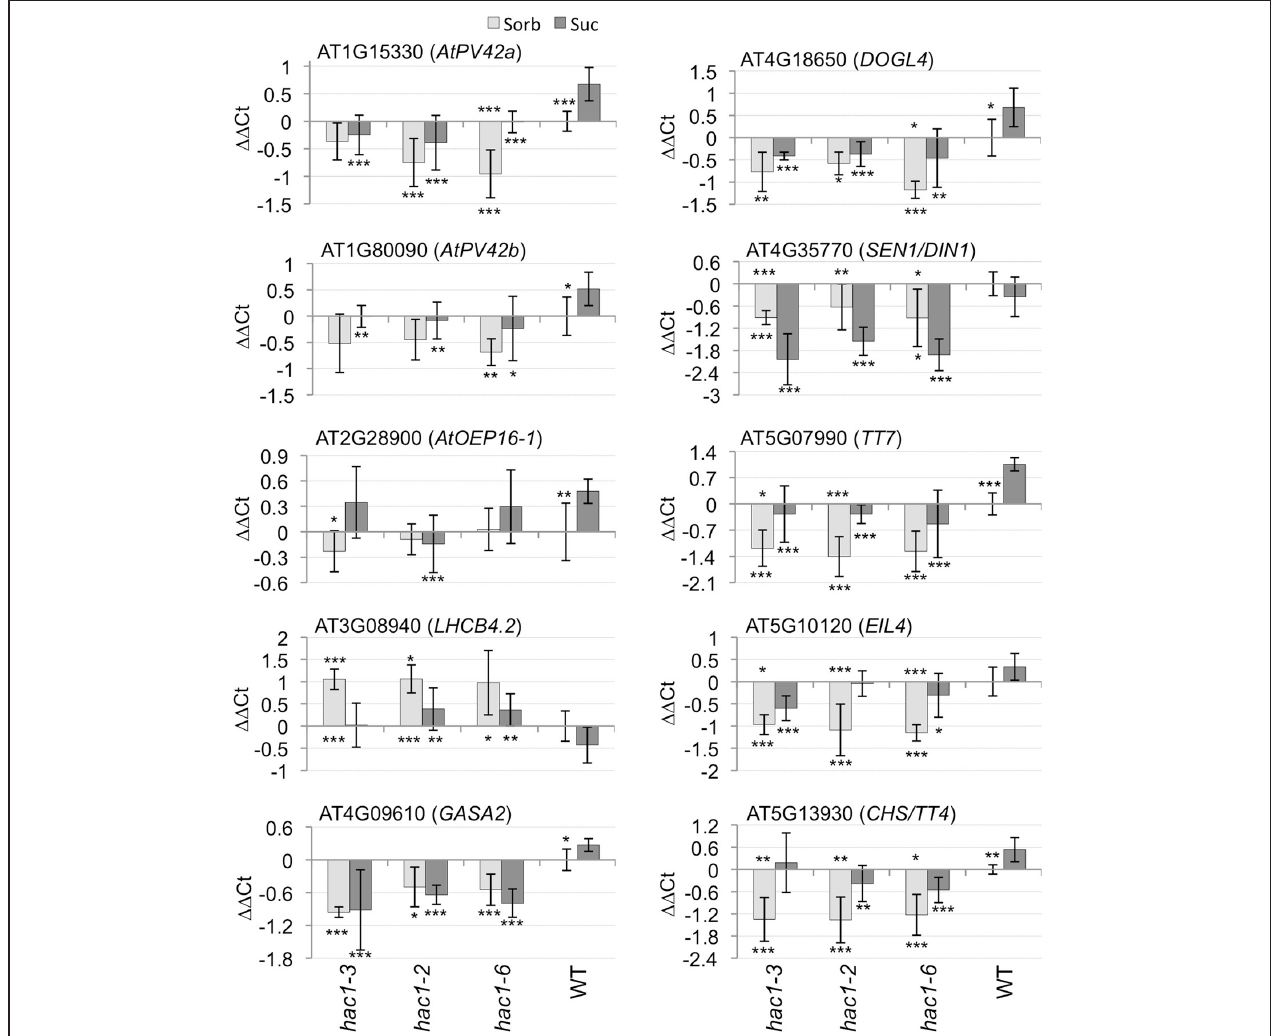
indicate that transcript levels for the indicated gene are higher in FIGURE 6 | Mutations in HAC1 cause altered expression of the indicated line on the indicated media than in wild-type seeds specific genes. Mutant and wild-type (WT) Arabidopsis seeds were incubated on sorbitol. Conversely, negative (cid:2)(cid:2) Ct values indicate surface sterilized and then incubated in the dark at 4 ◦ C for 3 days prior to being sown on nytex screens on Petri plates that transcript levels for the indicated gene are lower in the containing solid minimal Arabidopsis media. The seeds were indicated line on the indicated media than in wild-type seeds incubated under continuous light at room temperature for 20h, incubated on sorbitol. Two technical replicates were performed for and then the nytex screens and seeds were transferred to Petri each biological replicate. Error bars indicate standard deviations. plates containing Arabidopsis minimal media supplemented with The results of Student’s t -tests comparing transcript levels for 0.1M sorbitol (Sorb) or Suc. After an additional 12–13h, seeds seeds germinated on 0.1M sorbitol vs. seeds of the same line were harvested, followed by isolation of RNA. Quantitative RT-PCR germinated on 0.1M Suc are indicated by asterisks above the was then used to measure transcript levels. The transcript levels columns indicating the average transcript levels for seeds of ACT7 and UBQ6 were determined and the geometric means germinated on 0.1M sorbitol. The results of Student’s t-tests of their Ct used to normalize transcript levels. Transcript levels are comparing transcript levels in hac1 vs. wild-type seeds germinating expressed as (cid:2)(cid:2) Ct. (cid:2)(cid:2) Ct = (cid:2) Ct indicated gene in wild - type on sorbitol − on the same media are indicated by asterisks below the columns (cid:2) Ct indicating the average transcript levels for each hac1 allele on indicated gene in indicated line on indicated media . − (cid:2) Ct = Ct each media. ∗ p < 0 . 1; ∗∗ p < 0 . 05; or ∗∗∗ p < 0 . 02, according to a indicated gene in indicated line on indicated media Ct ACT7 / UBQ6 in same line on same media . Positive (cid:2)(cid:2) Ct values Student’s t -test. N =